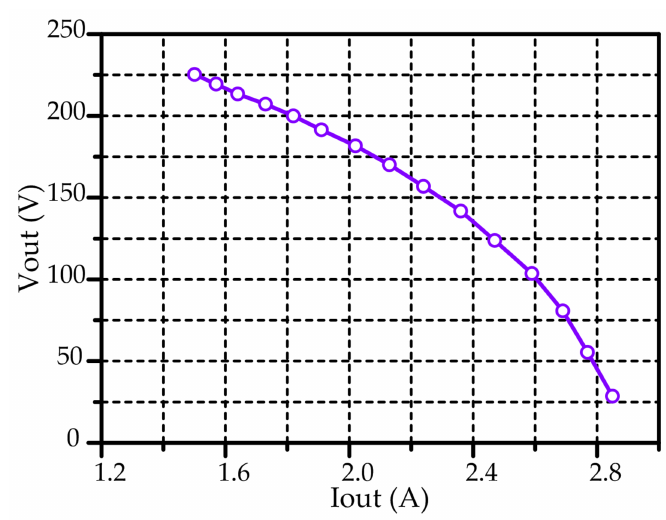
Figure 17. Variation of output voltage versus load current (2500 r/min).